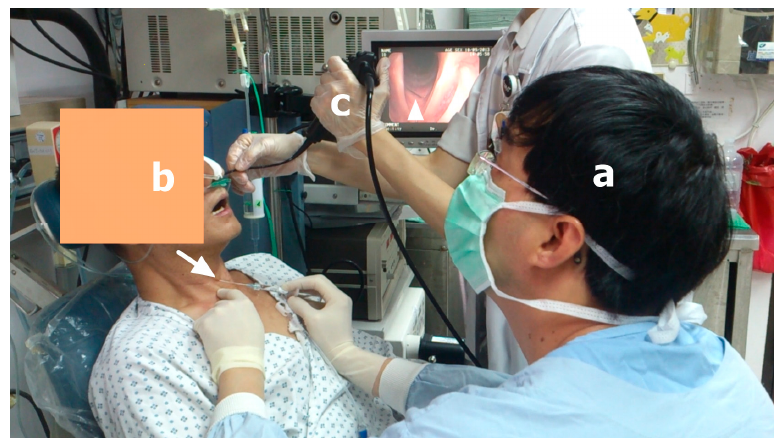
Figure 6. Hyaluronic acid injection laryngoplasty (arrow head) under local anesthesia, guided by flexible laryngoscopy, using the trans-cervical approach via cricothyroid membrane puncture (arrow). ( a ) Surgeon; ( b ) a patient in sitting position; ( c ) an assistant controls the scope.